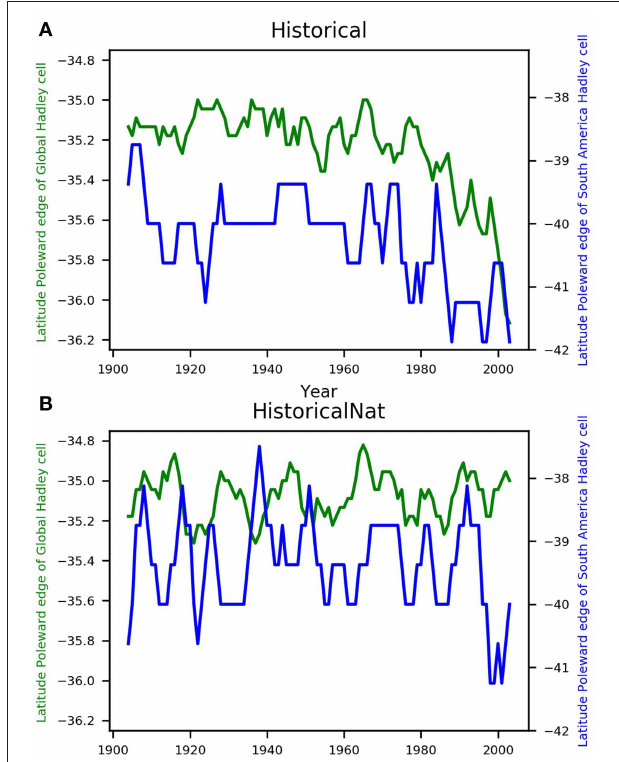
FIGURE 7 | Latitude of the poleward edge of the Global southern Hadley cell (green line) and South America Hadley cell (blue line) for the CMIP5 (A) Historical, and (B) HistoricalNat Simulations. Timeseries have been smoothed with a 5-year moving average.